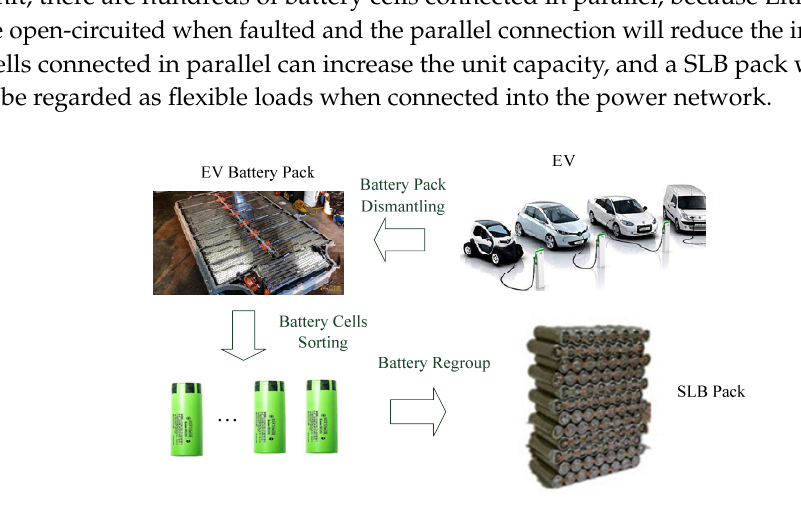
Figure 3. Battery cells are dismantled from electric vehicle (EV) and regrouped to a second life batteries (SLB) pack.